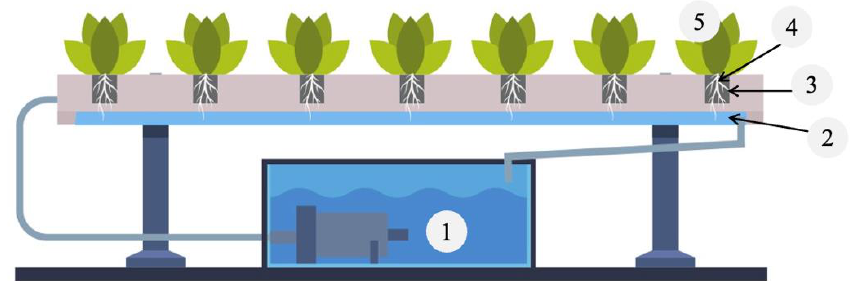
Figure 2. Samples (N = 200) were collected from the nutrient flow technology (NFT) system at 1-, 12-, and 24-h, and 7-, 14-, 21- and 28-days post-inoculation with Salmonella enterica serotype Typhimurium (LT2 JSG626) or Listeria monocytogenes (ATCC 19111). Five replicate samples of nutrient solution from the reservoirs (1) and channels (2), and from rockwool (3), roots (4), and shoot tissue (5) were collected.